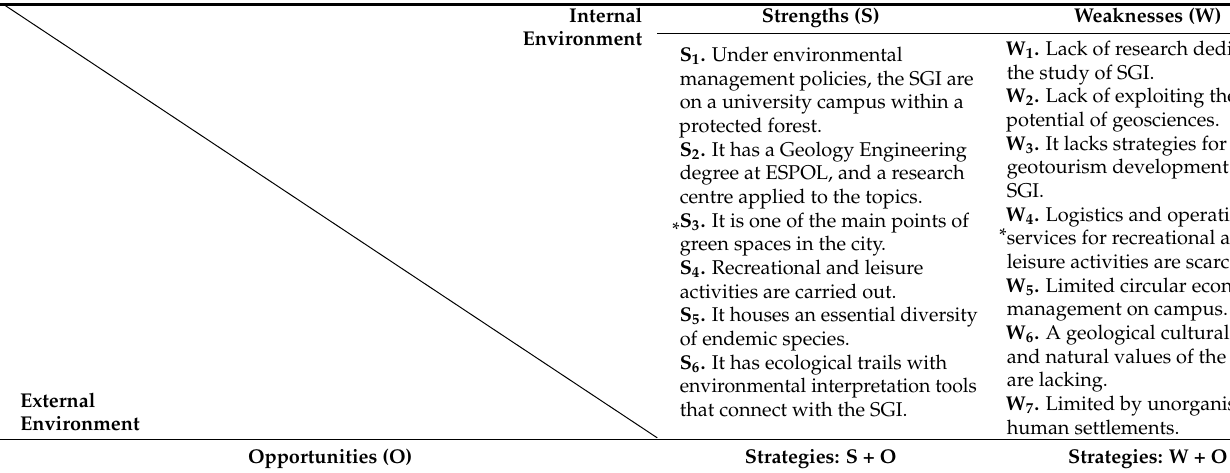
Table 7. Strengths, weaknesses, opportunities, and threats (SWOT)